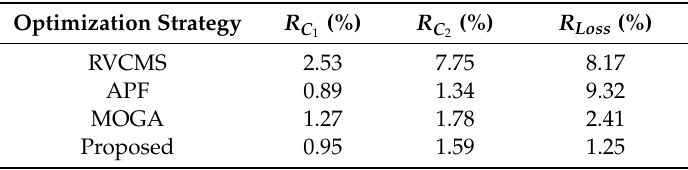
Table 9. Performance comparison of multiple optimization